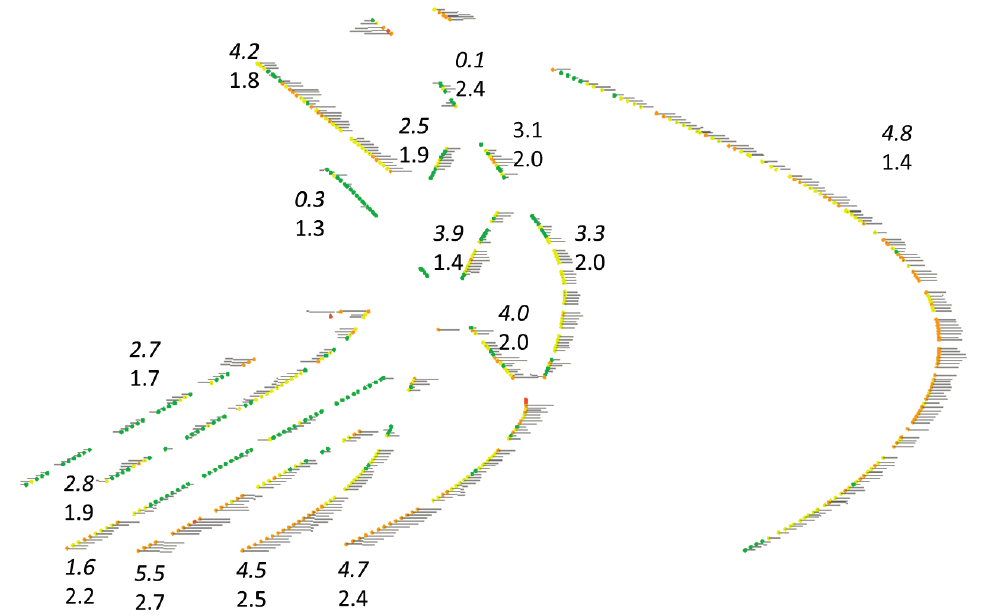
Figure 12. Residuals between centerlines from data-driven approach and reference data in Sittard: top value is the systematic offset, bottom value represent the standard deviation of the residuals per track. Grey lines represent the direction and magnitude of the residuals (magnified by a factor